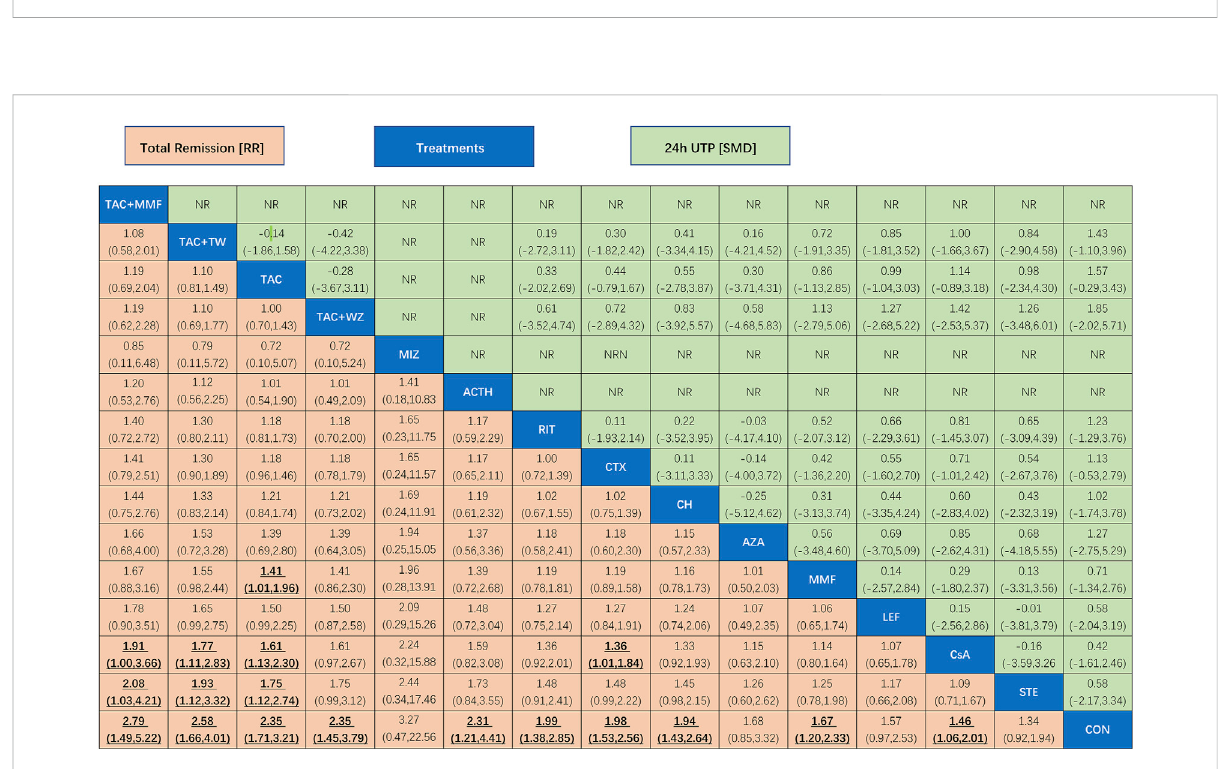
FIGURE 3 Result of network meta-analysis for total remission and 24-h urine total protein. ACTH, adrenocorticotropic hormone; AZA, azathioprine; CH, chlorambucil; CON, non-immunosuppressive therapies (the control group); CsA, cyclosporine; CTX, cyclophosphamide; LEF, le fl unomide; MMF, mycophenolate mofetil; MZB, mizoribine; RIT, rituximab; STE, steroids; TAC, tacrolimus; and TAC + MMF, tacrolimus combined-mycophenolate mofetil.